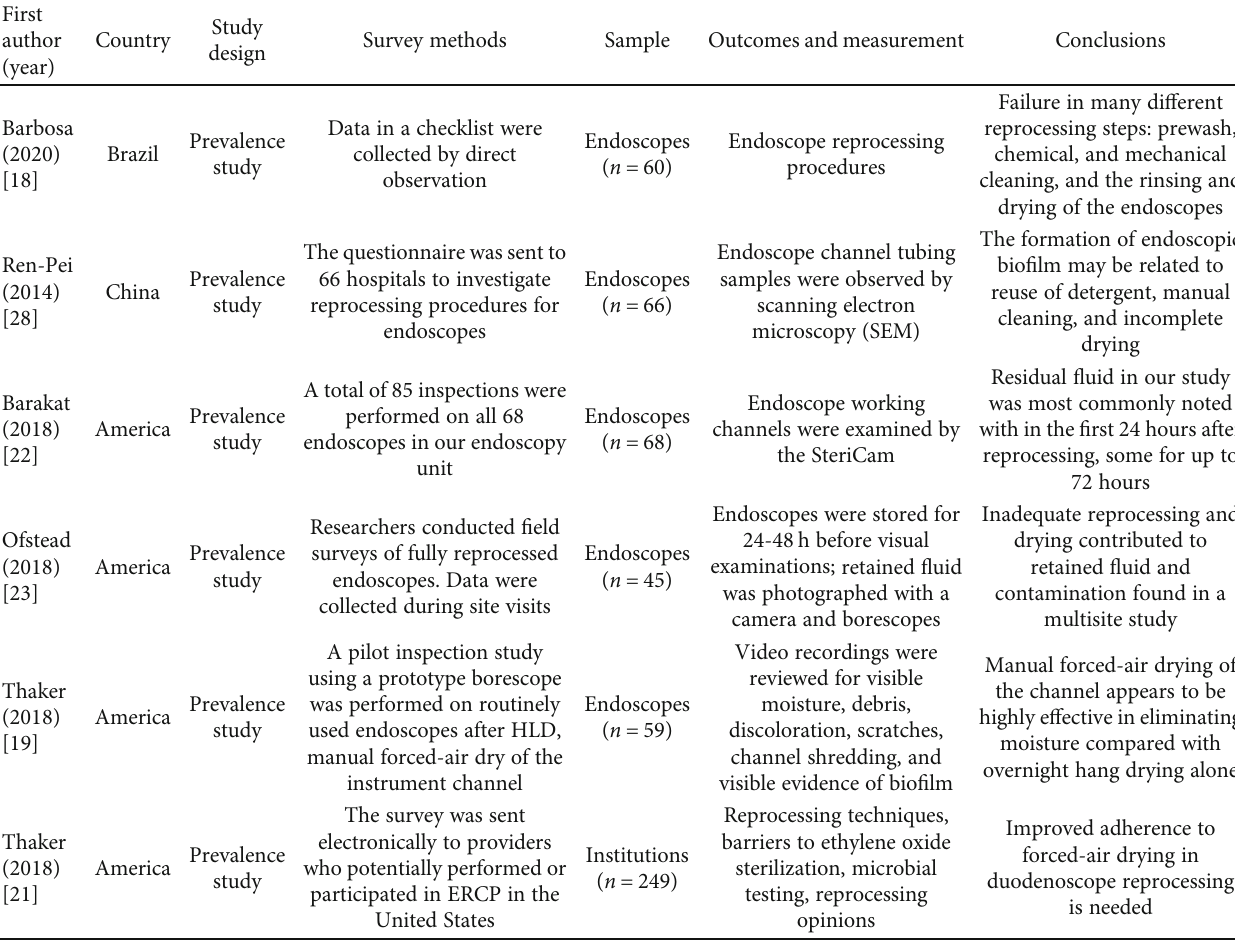
Table 2: Characteristics of the prevalence